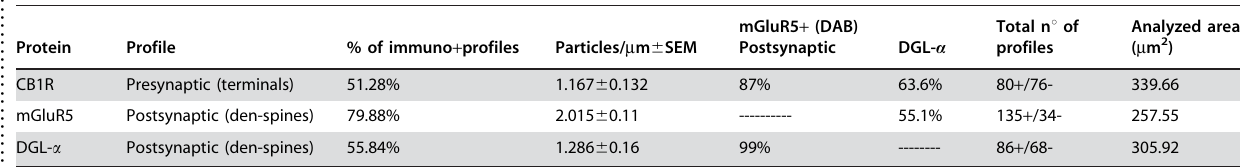
Table 1. Percentage of presynaptic and postsynaptic elements immunoreactive for CB1R, mGluR5 or DGL- a . .. ... .... ... ... .... ... ... .... ... ... .... ... ... .... ... ... .... ... ... .... ... ... .... ... ... .... ... ... .... ... ... .... ... ... .... ... ... .... ... ... .... ... ... . Protein